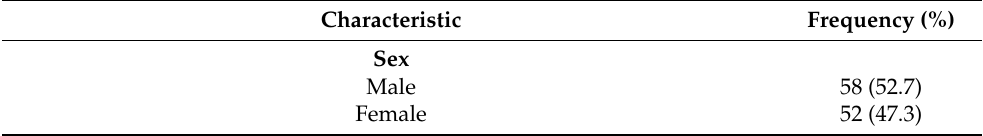
Table 1. Patient and facility